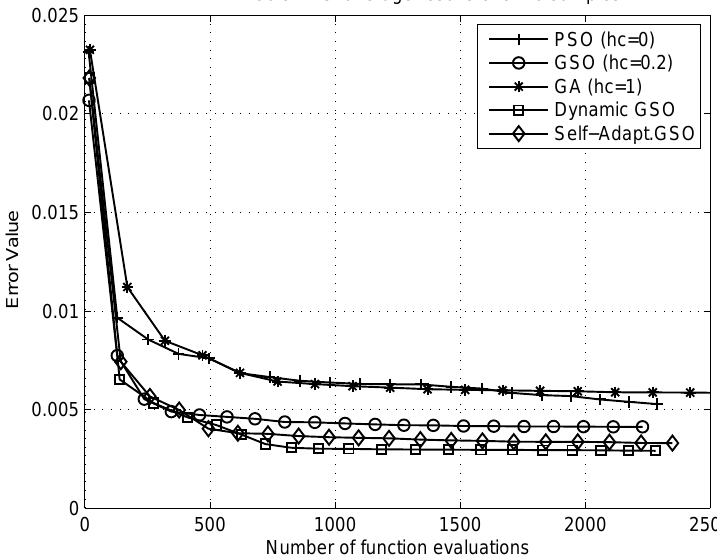
Figure 3. Fitness value evolution for TEAM problem 25 optimized with different GSO hybridization strategies (from